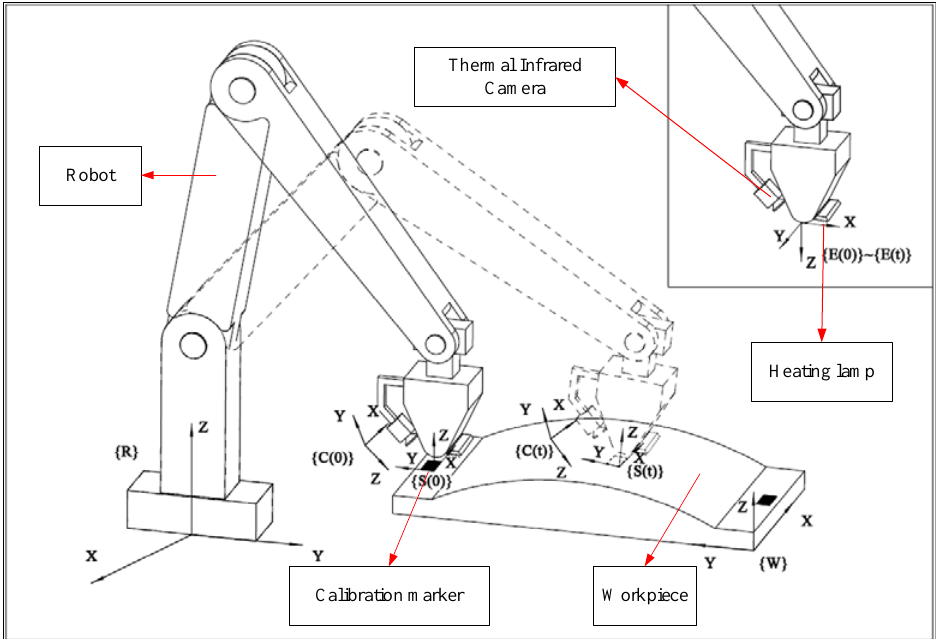
Figure 3. Infrared visual measurement system.